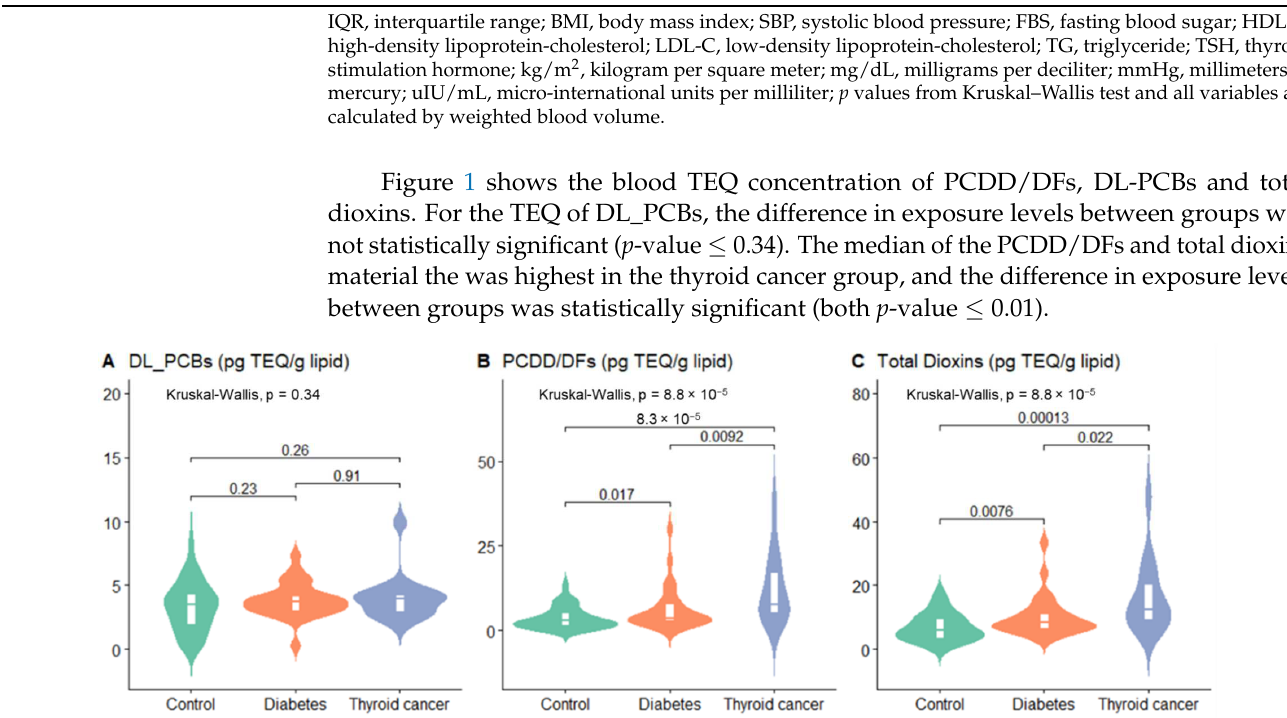
Figure 1. Serum concentrations for PCDD/DFs, DL-PCBs of the study group. Violin plots show differences in blood of concentrations for DL_PCBs ( A ), PCDD/DFs ( B ), total dioxins ( C ) at the controls group ( n = 55), type 2 diabetes ( n = 30) or thyroid cancer ( n = 15). The line in the white box represents the median. The width of the shape represents blood concentration density, and the length illustrates the range of the blood